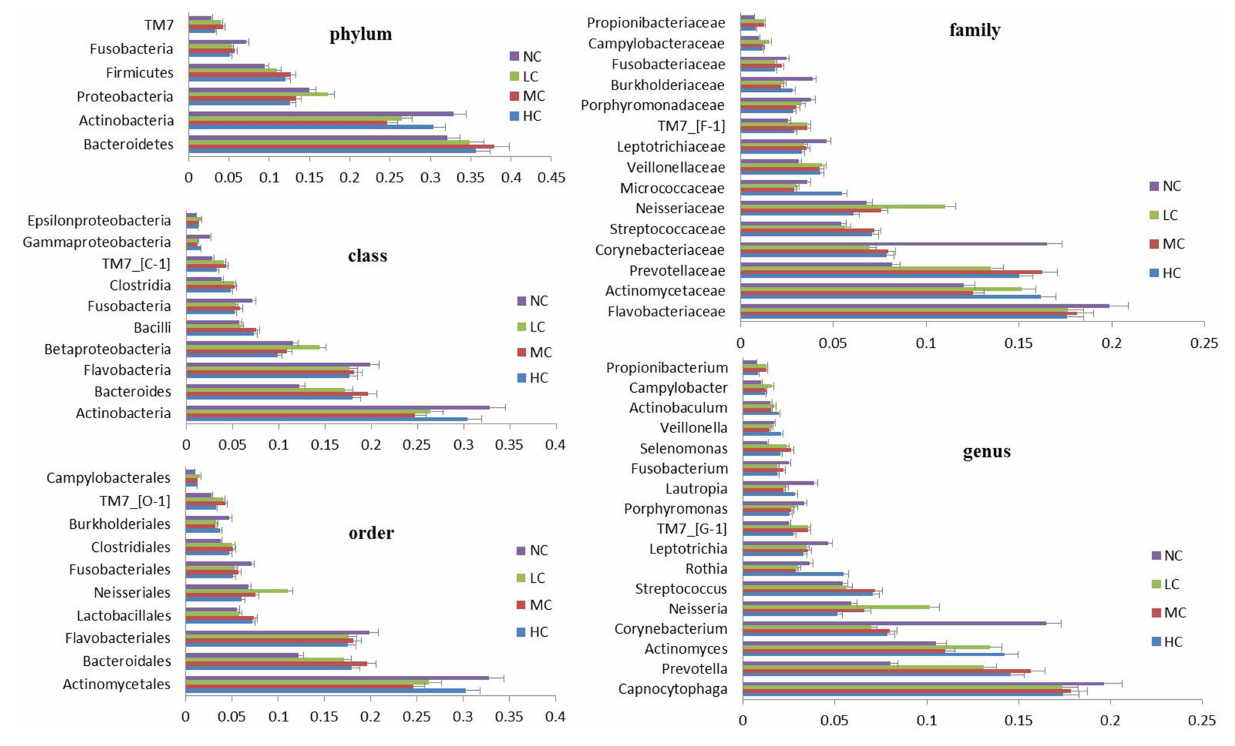
FIGURE 1 | Distribution of the predominant bacteria at different taxonomic levels (phylum, class, order, family, and genus). The predominant taxa ( > 1% relative abundance) in each level are